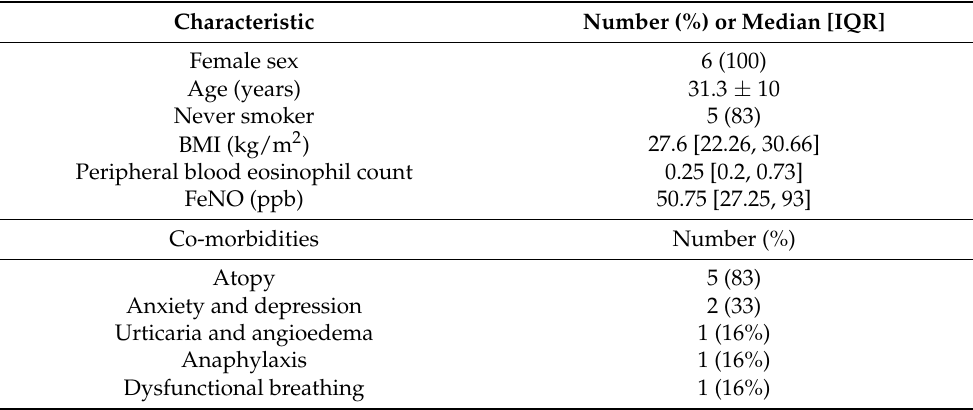
Table 1. Participant demographics and